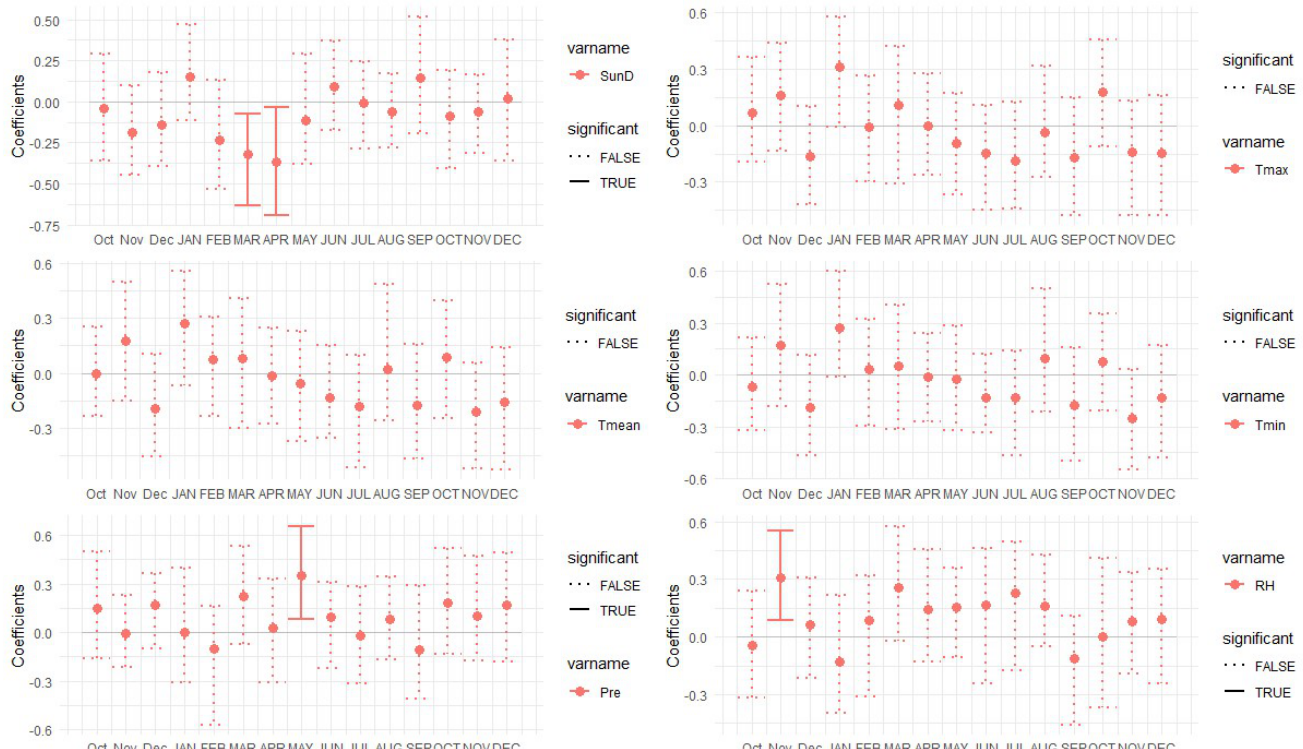
Figure A6. Correlation coefficient between TRW and climate during 1986–2014.